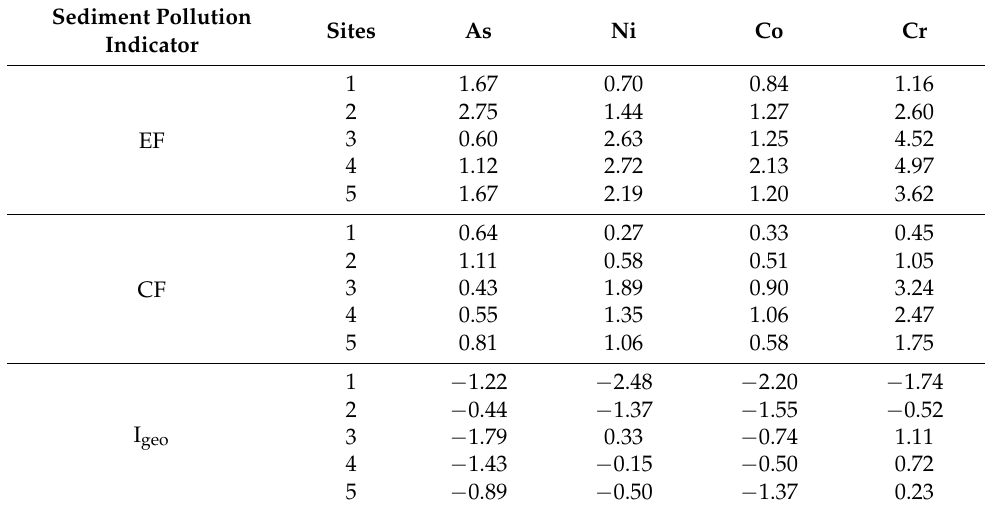
Table 3. Sediment pollution indicators in sediments from Algeciras